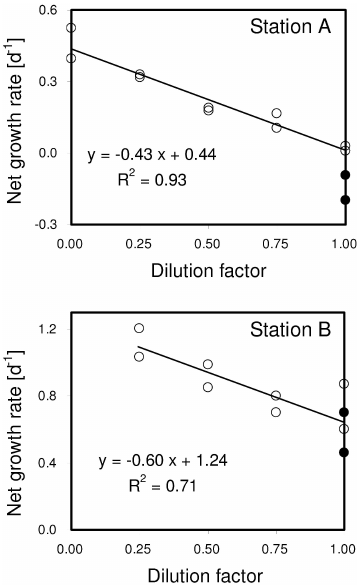
Figure 8. Temporal variations of chlorophyll a (Chl a ) and phos- phate (PO 4 ) during incubations with and without nutrient enrich- ments in stations A and B. Dashed lines (filled symbols) are for chlorophyll a on the left axis with thin lines (open symbols) for phosphate on the right axis; control is the incubation of raw seawa- ter without nutrient